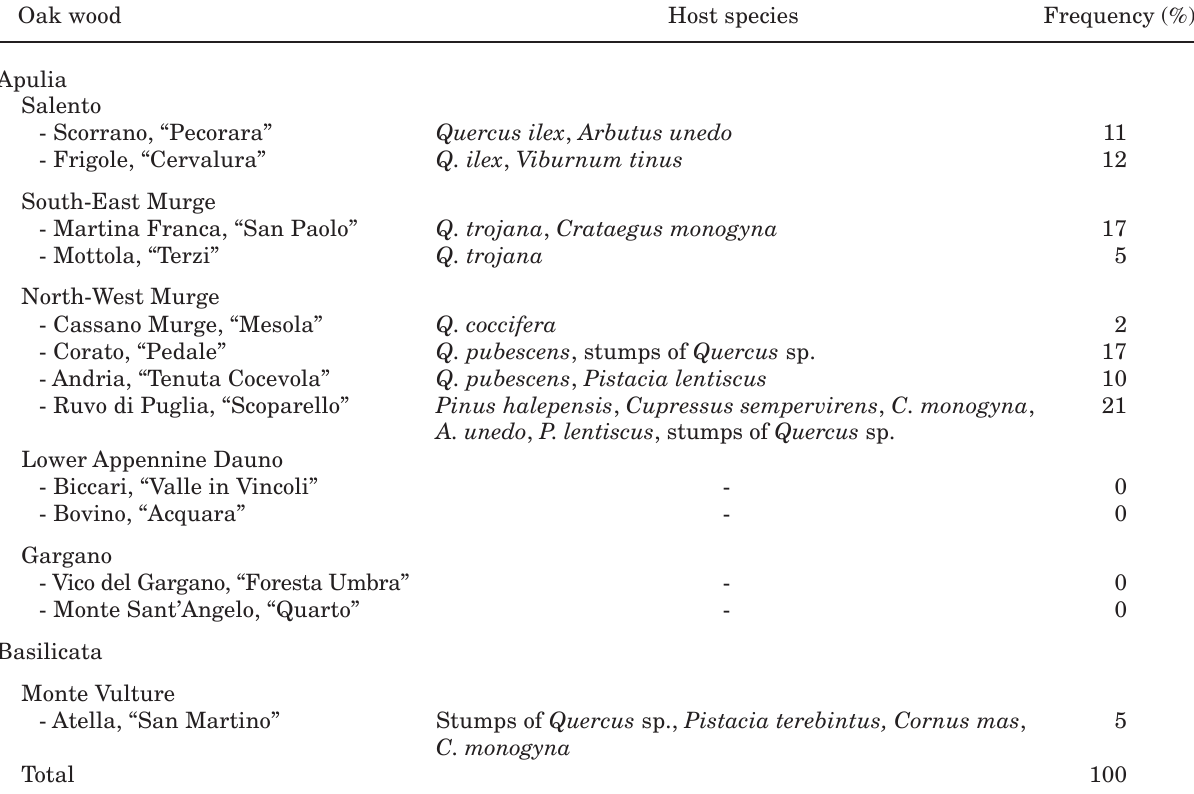
Table 1. Frequency of occurrence (%) of host species with Phellinus torulosus basidiomes in the different localities and oak woods